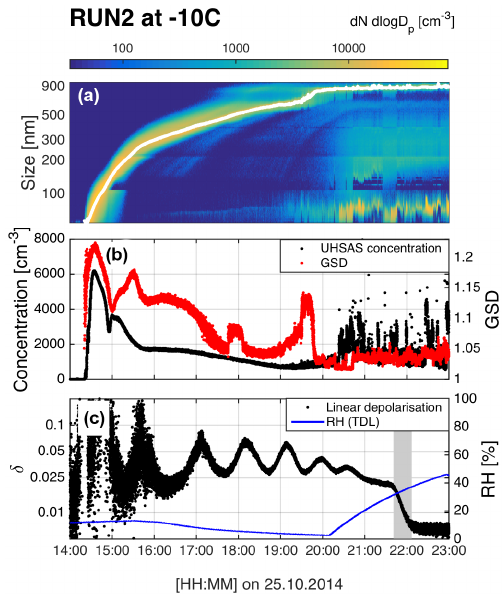
Figure 5. Overview of the reference run at − 20 ◦ C. As for Fig. 4, panel (a) shows the particle size distribution and the GMD from a log-normal fit. Panel (b) shows the total concentration measured with the UHSAS (with 56nm cut-off) and the GSD determined from a log-normal fit. Panel (c) shows the time development of the linear depolarization ratio and the RH. During the reference run the RH was kept over 60% during the growth of the SOA particles to ensure that they remained in low viscous state during growth. At the begin- ning of the growth (06:00–07:00), the SOA particles were too small to efficiently scatter light and the signal shown in panel (c) at that time is mostly noise. After the particles were larger than 100nm, the linear depolarization ratio stayed below the detection threshold, indicating a low viscous state of the particles and verifying the ab- sence of measurement